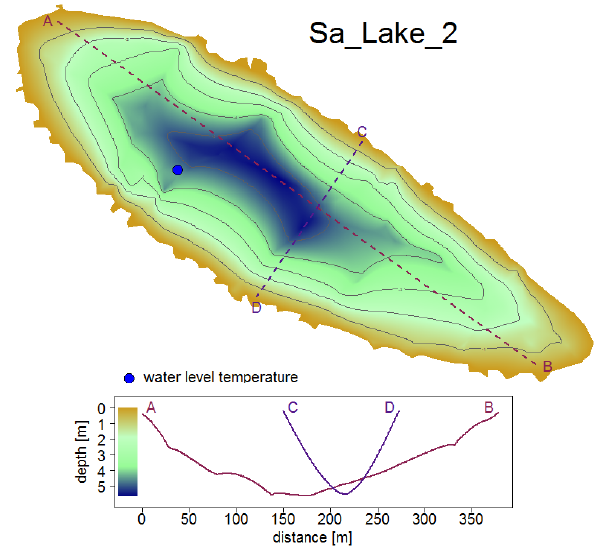
Figure A2. Bathymetry and cross sections of Sa_Lake_2 with loca- tion of